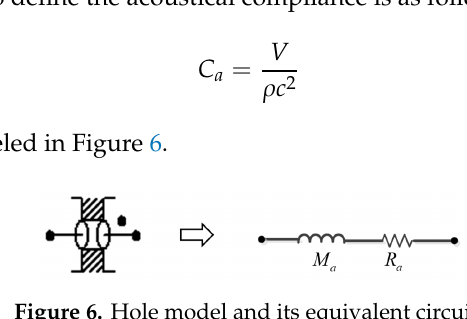
Figure 5. Cavity model and its equivalent circuit.